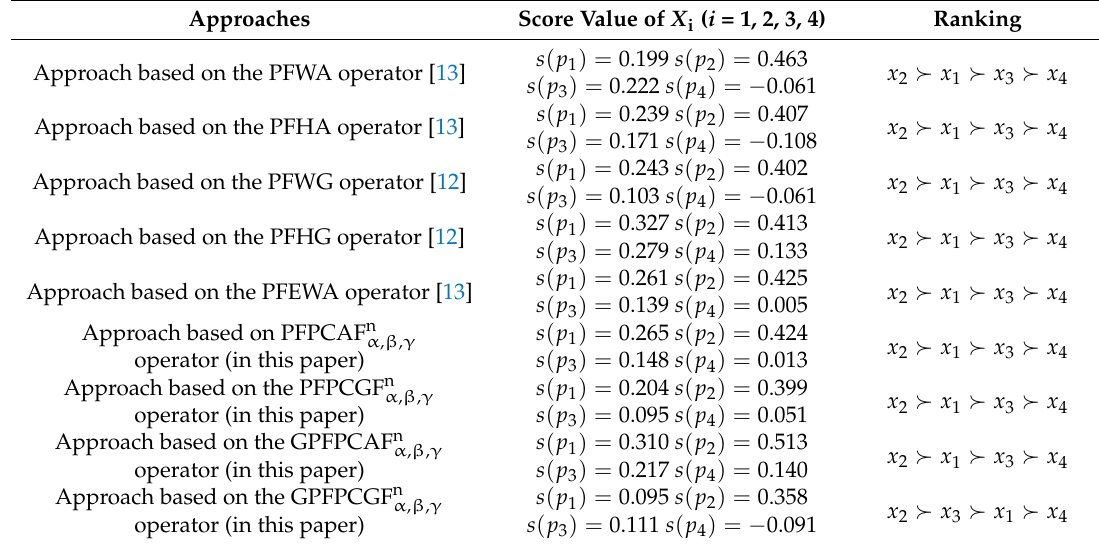
Table 5. Comparison of rankings with different aggregation operators.